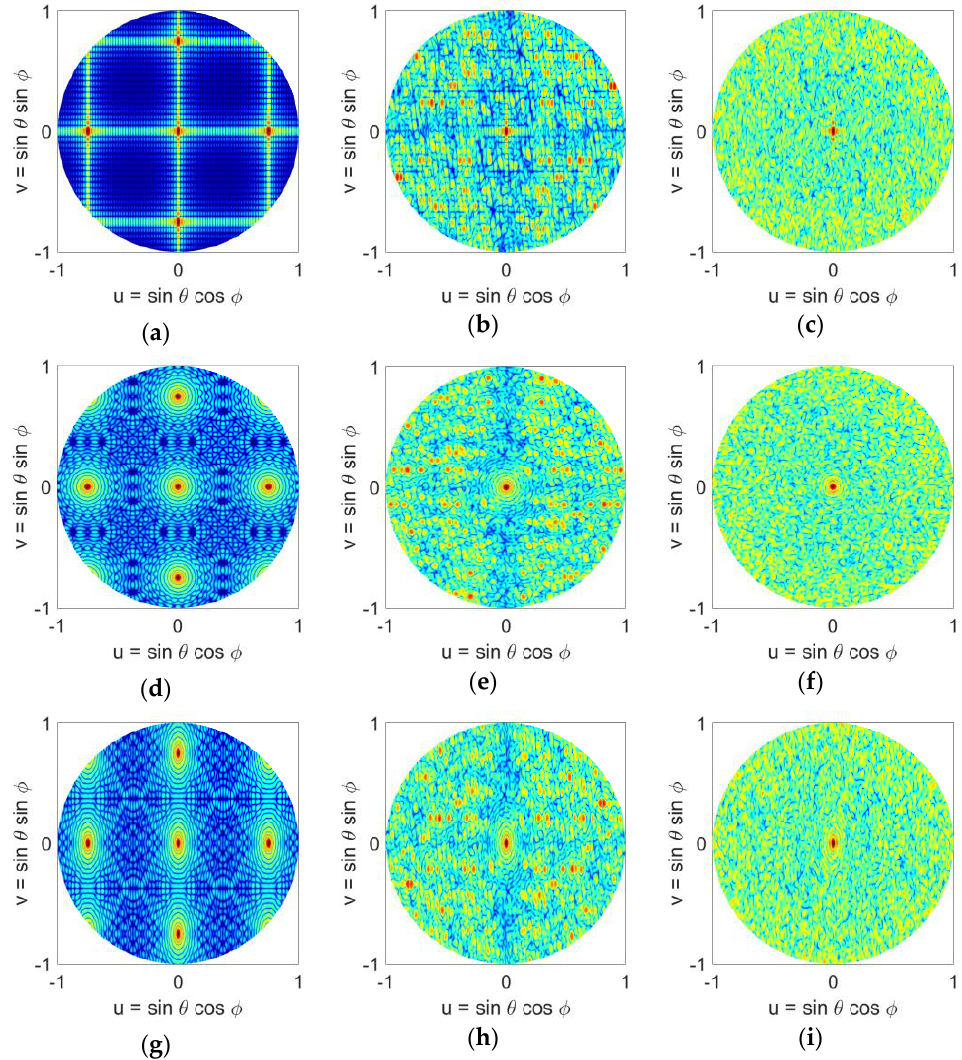
Figure 8. Normalized power patterns of sparse antenna arrays with rectangular, circular, and elliptical apertures and different element distributions in the u-v space: ( a ) uniform (rectangular), ( b ) Halton (rectangular), ( c ) Poisson disk (rectangular), ( d ) uniform (circular), ( e ) Halton (circular), ( f ) Poisson disk (circular), ( g ) uniform (elliptical), ( h ) Halton (elliptical), ( i ) Poisson disk (elliptical).